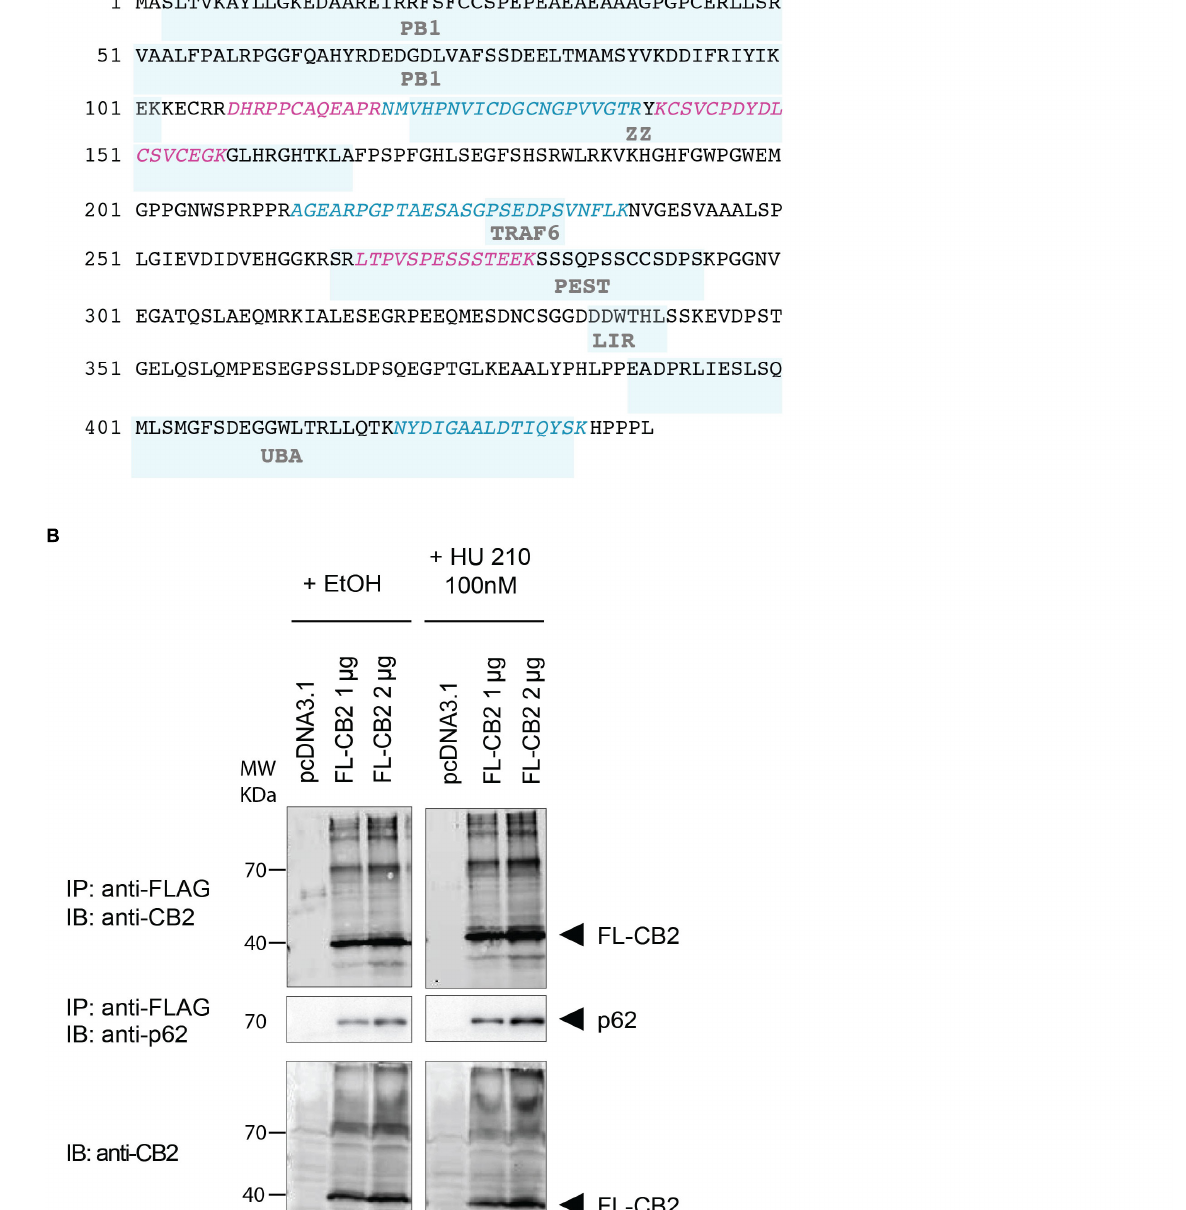
Frontiers in Molecular Neuroscience |